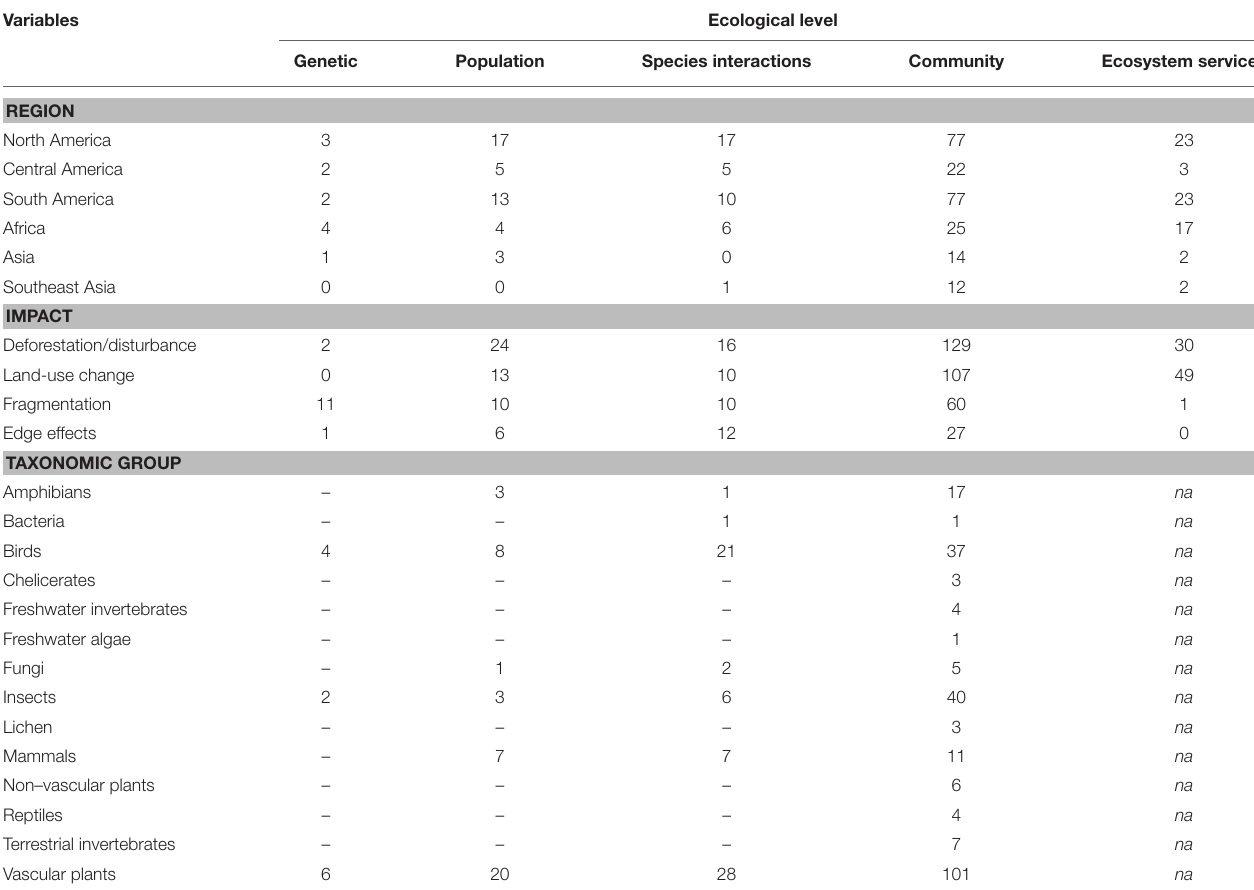
TABLE 2 | Number of articles on the impact of habitat degradation of tropical montane forests at various ecological levels distributed across regions, impact types and taxonomic groups. Variables Ecological level Genetic Population Species interactions Community Ecosystem